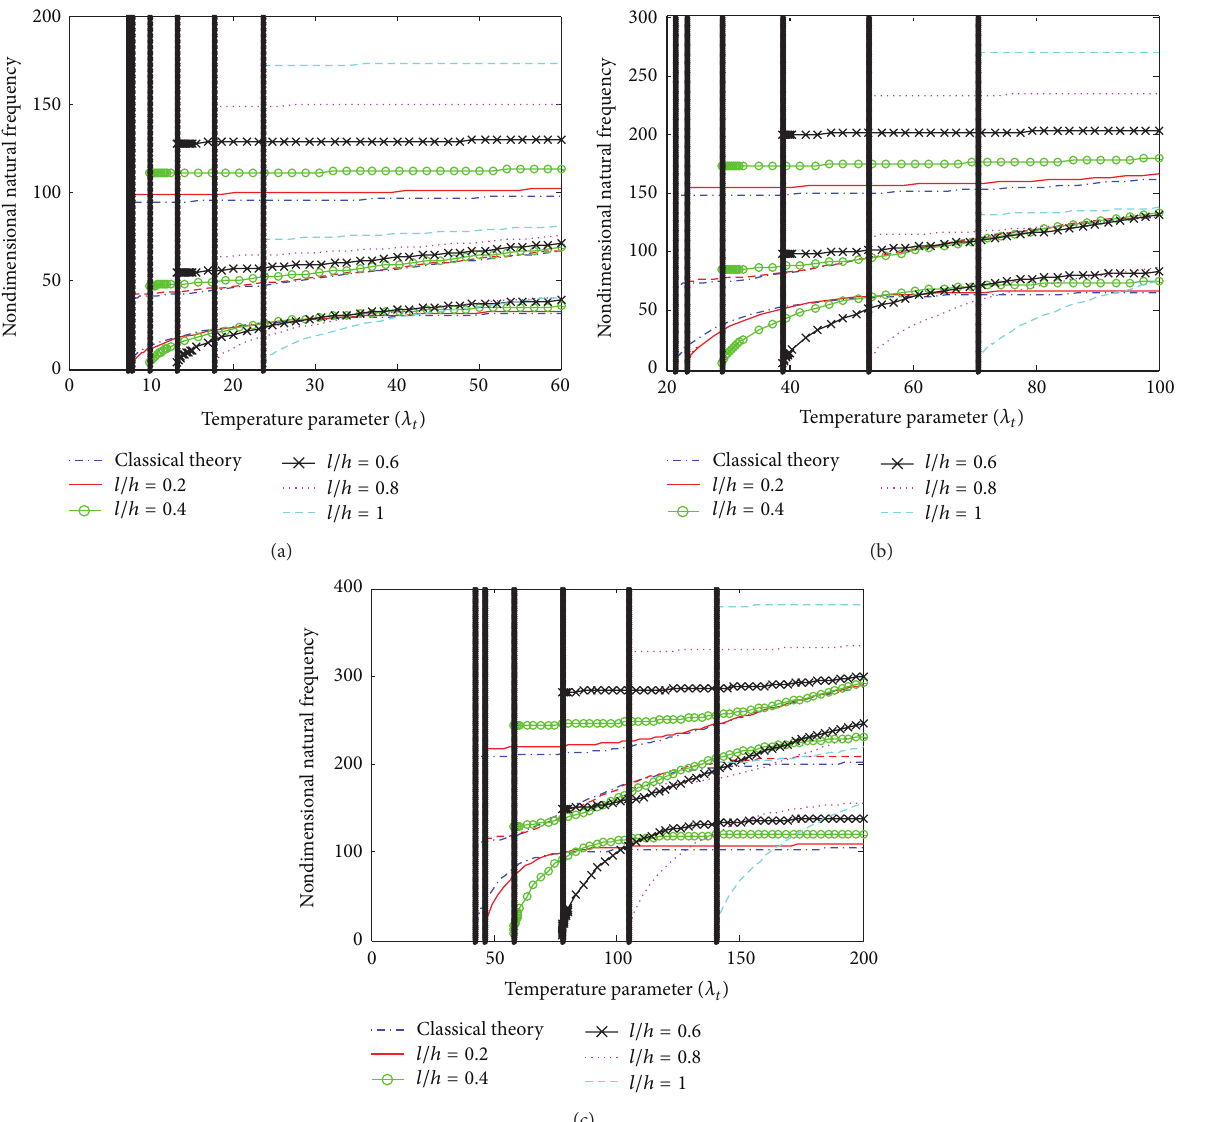
Figure 12: Variation of the nondimensional natural frequency of vibration around the (a) first, (b) second, (c) third buckling mode with the temperature parameter for a clamped-simply supported FG beam with different values of 𝑙/ℎ ( 𝑘 = 1 , 𝐿/ℎ = 40 ).